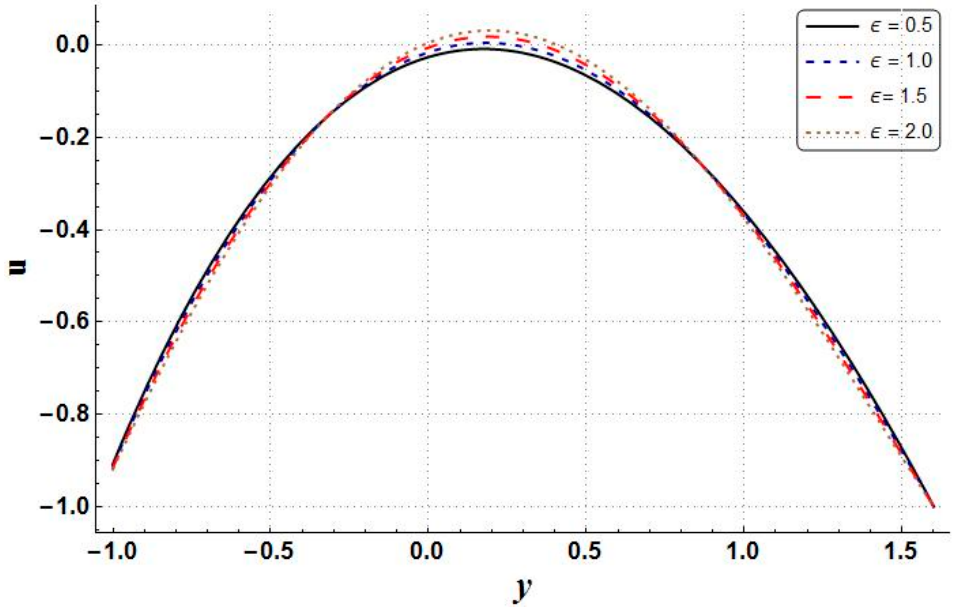
Figure 12. Influence on u through changing values of k , where γ = π φ = 0.05, m = 1, a = 0.6, M = 1, d = 0.7, Br = 0.2, b = 0.5, ∈ = 2, η = 0.8.